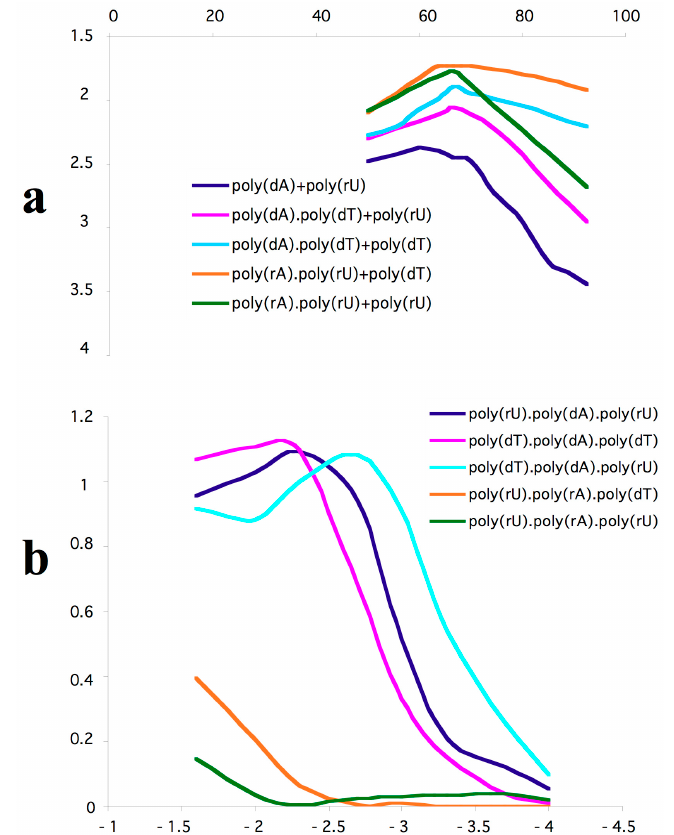
Figure 1. Mixing curves of homopolymeric nucleic acid complexes assembled by adding either poly-deoxyadenylic acid or poly-uridilic acid ( a ). Cumulative percentage of poly-pyrimidic nucleic acid addition (X axis) was plotted relative to the corresponding absorbance measured at 260 nm (Y axis). The reactivity of samples that displayed the highest hypochromicity to antibodies to poly(rU).poly(dA).poly(rU) was measured in immunosorbent assays ( b ). Curves were obtained by plotting logarithmic values of antibody concentrations (X axis) and the corresponding absorbance measured at 405 nm (Y axis). Data for graph construction were taken from [15].